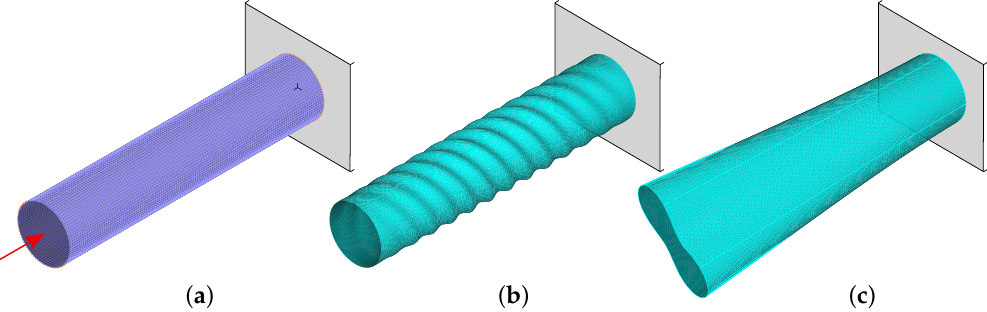
Figure 1. The FE model ( a ) and examples of the first buckling form ( b ) and the first mode shape ( c